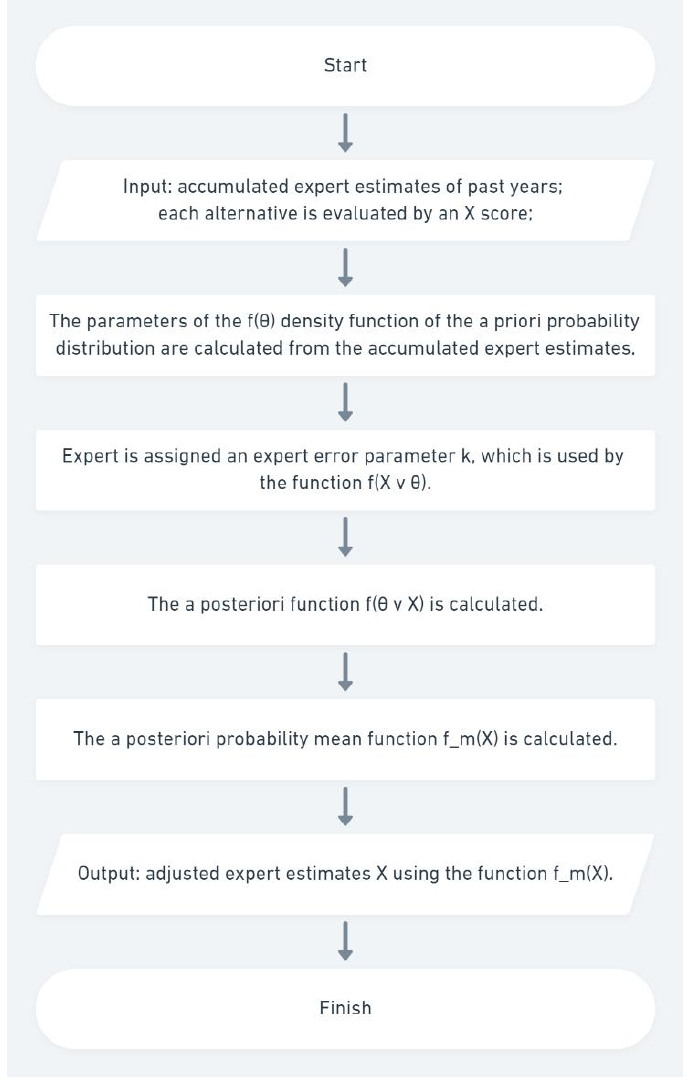
Figure 1. The flowchart presenting the procedure of the proposed Bayesian approach.